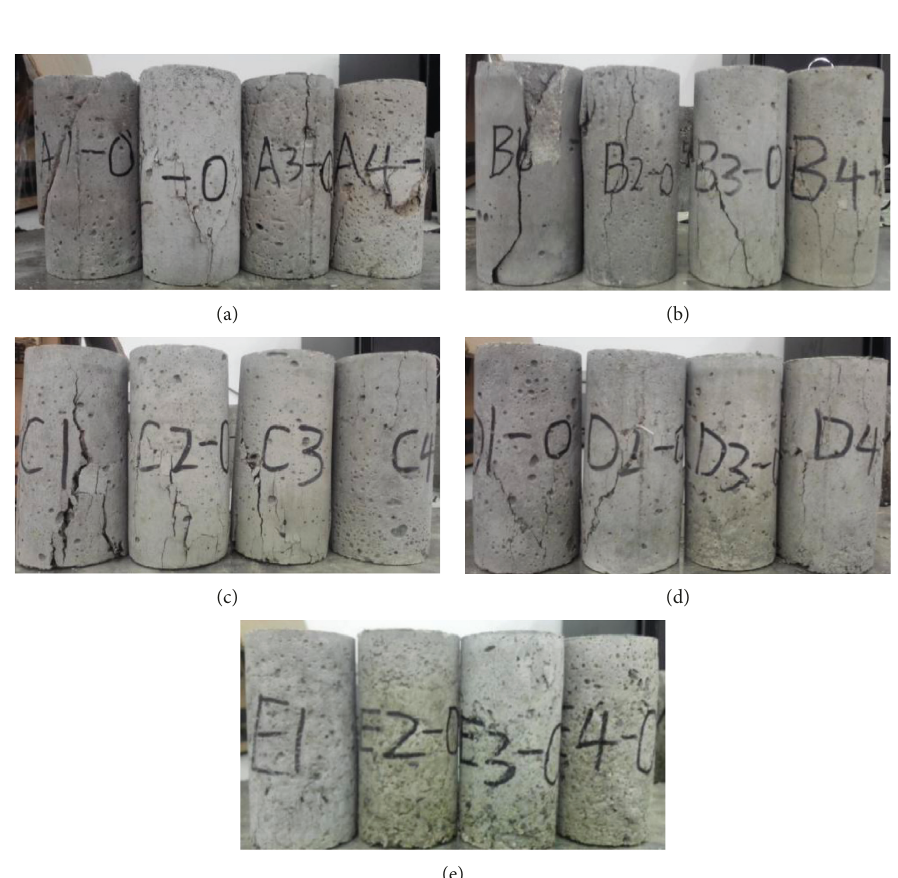
Figure 2: Uniaxial failure modes of basalt fiber rubber particles mortar: (a) A group; (b) B group; (c) C group; (d) D group; (e) E